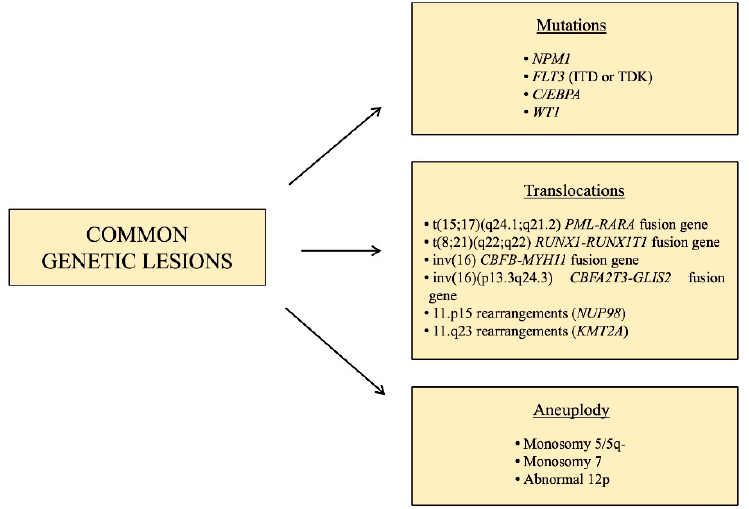
Figure 1. Schematic resume of the main recurrent genetic lesions found in pediatric AML.